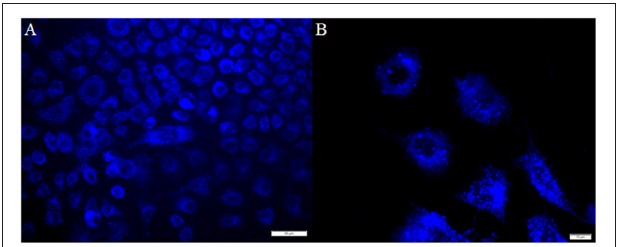
FIGURE 2 | Labeling pattern of B2 . HeLa cells were seeded on coverslips and incubated with 50 µ g/mL B2 for 30min at 37 ◦ C prior being fixed and analyzed by fluorescence microscopy. Bar size 50 µ m (A) and 10 µ m (B) . We found similar results with a shorter (15min at 37 ◦ C) incubation and/or with 25 µ g/mL B2 ; albeit not staining was observed with 12.5 µ g/mL B2 (data not shown).